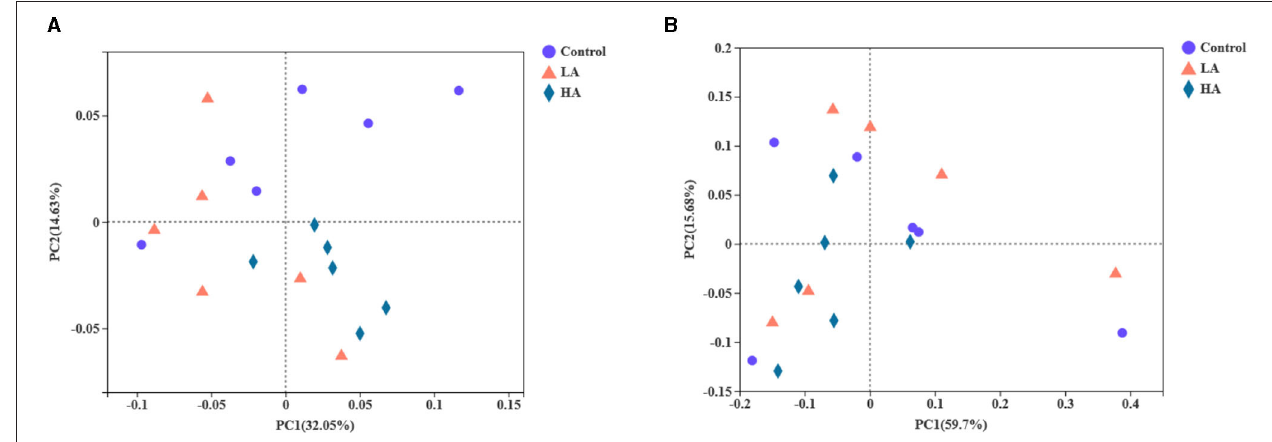
FIGURE 2 | Effect of anthocyanin-rich purple corn on ruminal fluid beta diversity analysis. (A) PCoA based on unweighted unifrac distance. (B) PCoA based on weighted unifrac distance. LA = basal diet + 0.5-g/d PCP; HA = basal diet + 1-g/d PCP.